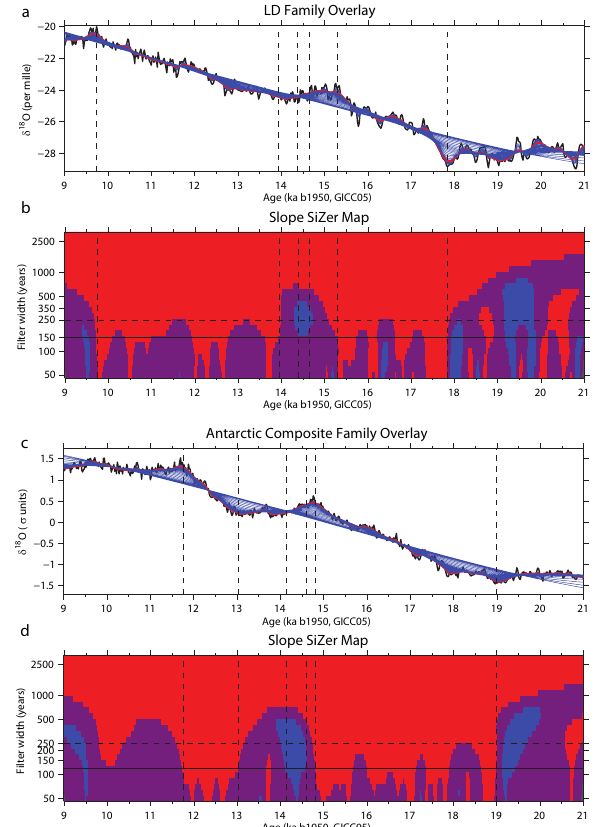
Fig. 3. SiZer maps of the significance of features in LD δ 18 O ice and the Antarctic composite through the deglaciation. (a) LD Fam- ily Overlay: the series of blue curves shows LD δ 18 O ice smoothed across a range of filter widths from 40 to 3000yr, the black curves show the original data and the red curve shows the 150yr smooth. (b) LD Slope Sizer Map: the significance and sign of the slope of the smoothed data is shown, as the filter width (on the vertical axis) is varied; red signifies significant positive slope (warming), blue signifies significant negative slope (cooling), and purple signifies re- gions where the slope is not statistically different from zero (all with respect to the 95% CL); for instance, the significant cooling during the ACR appears as the blue area in the centre of the figure. The timing of significant climate features at LD is interpreted from the intercepts of the 150yr smoothing (horizontal solid line) with the changes in the significance and/or sign of the slope (see Sect. 2.3.1). Significant features are marked with dashed vertical lines. The tim- ing and dating uncertainty of climate features are listed in Table 4. (c) Antarctic Composite Family Overlay: interpret as above except that the red curve shows the 120yr smooth. (d) Antarctic composite Slope SiZer Map: the timing of significant climate features is inter- preted from the intercepts of the 120yr smoothing with the changes in the significance and/or sign of the slope (see Sect.